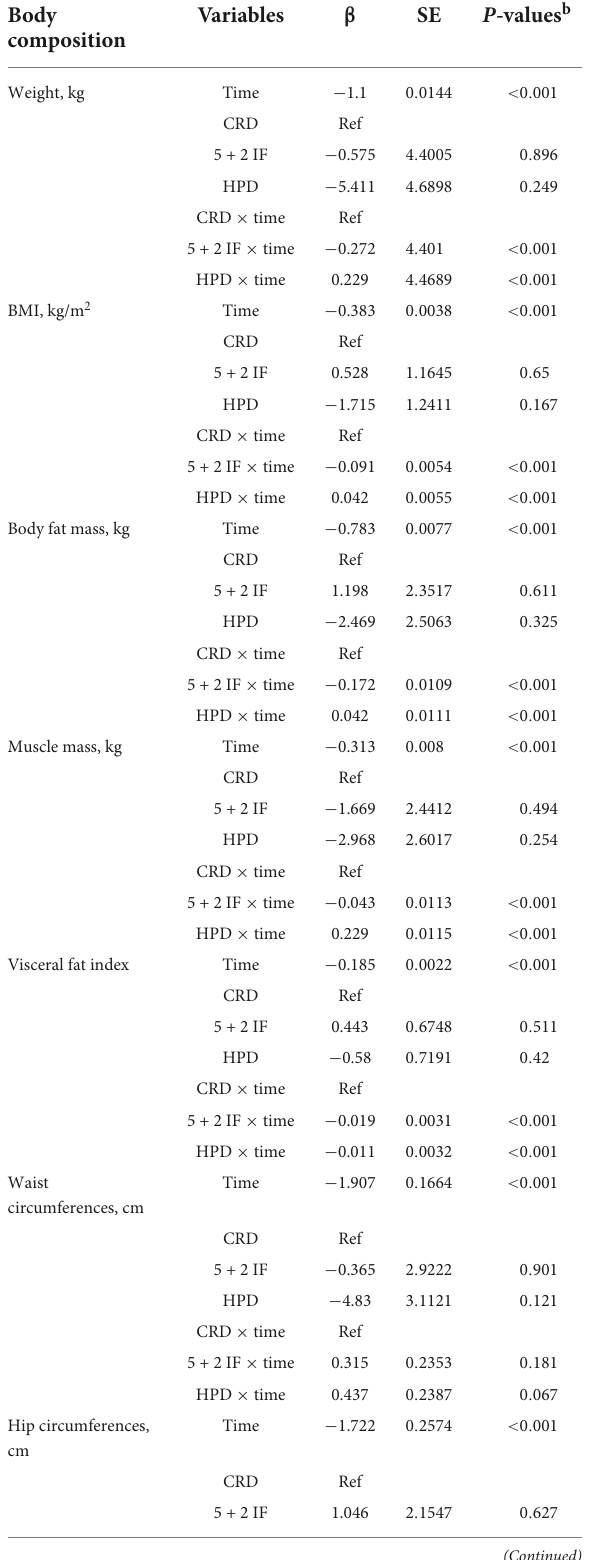
TABLE 2 Adjusted model for body composition and body mass index (BMI) results at baseline and 3 months among three groups in a randomized, placebo-controlled trial.